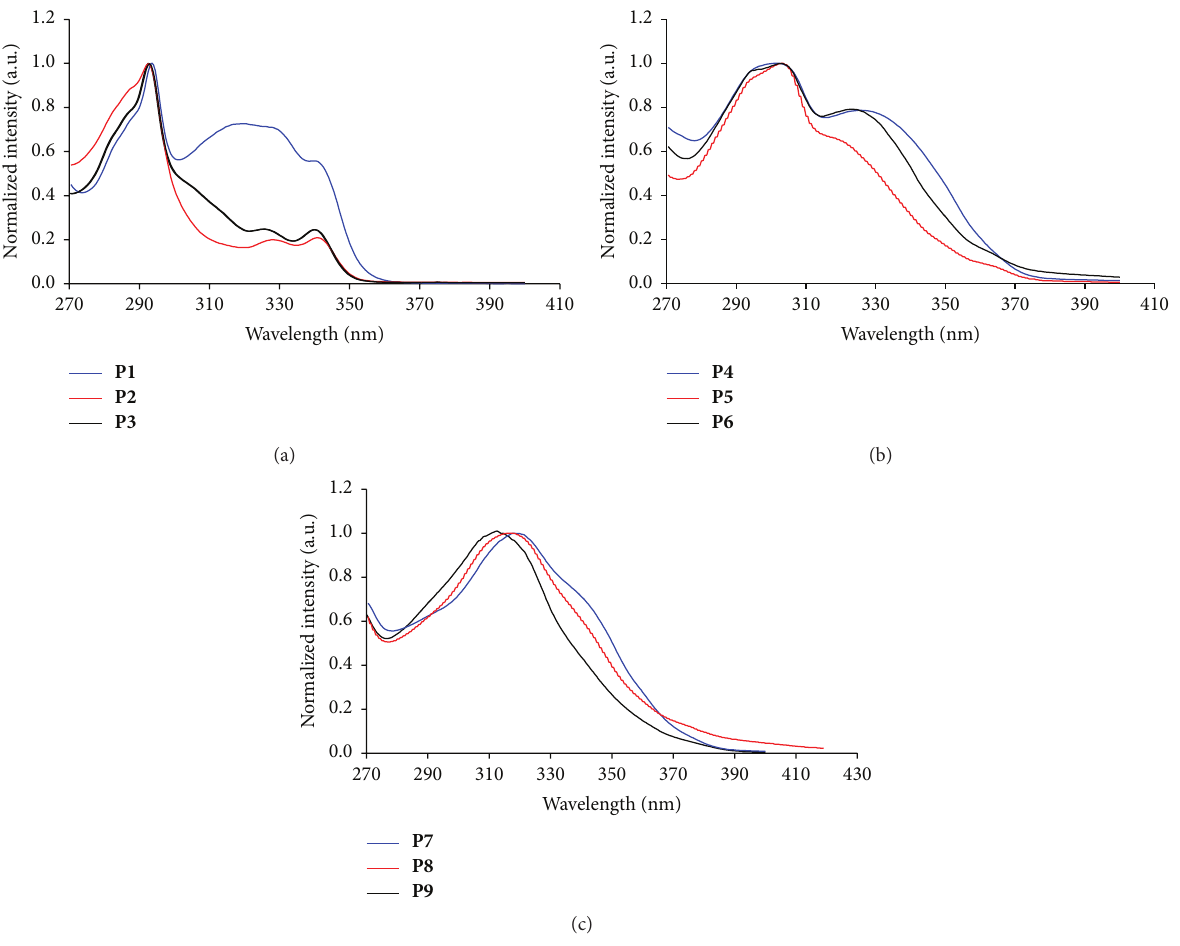
Figure 3: Electronic absorption spectra of (a) P1 , P2 , and P3 ; (b) P4 , P5 , and P6; and (c) P7 , P8 , and P9 recorded in DMF at 30 ∘ C.